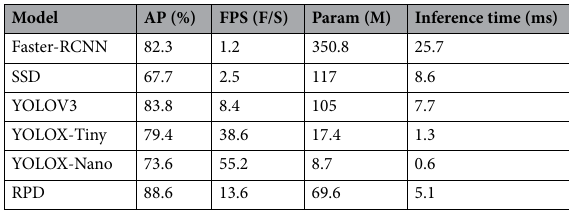
Table 1. Comparison of the algorithm performance.